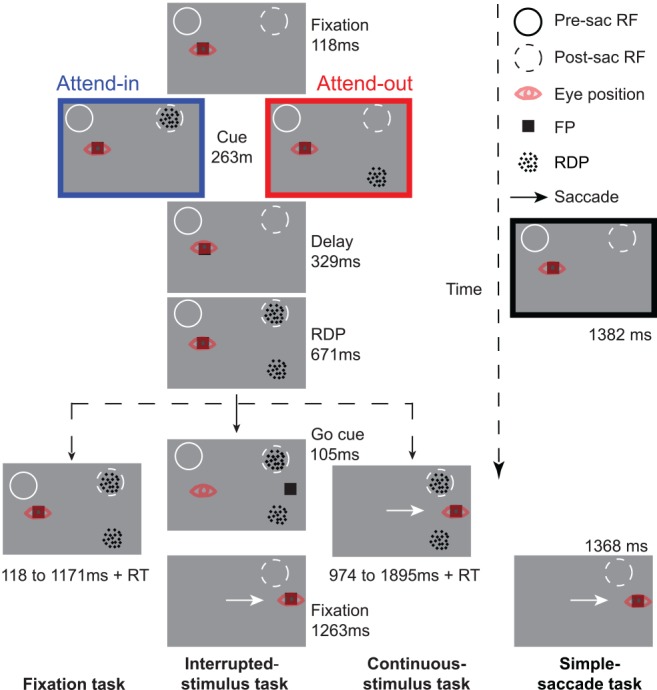
Task design and timing.Two rhesus monkeys were trained to perform a task that involved attending to one of two moving RDPs while also making a visually guided saccade if the fixation point jumped to a new location (continuous-stimulus task and fixation task). On about 44% of trials, the RDPs disappeared just before the saccade (interrupted-stimulus task). On about 11% of trials, RDPs were never presented and the monkey only had to make a visually guided saccade (simple-saccade task). Values next to each panel represent the durations of the task phase represented by that panel. For details, see Materials and Methods and S1 Text.